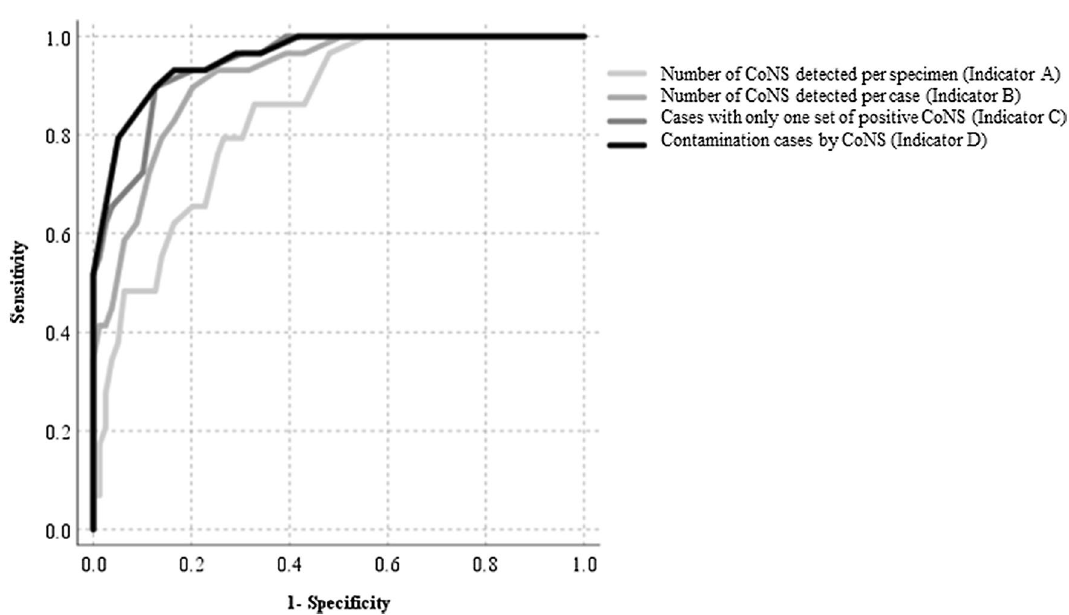
Figure 2. ROC curve predicting ConR 2.5 or higher and AUC comparison. CoNS coagulase-negative staphylococci, ConR contamination rate, AUC Area under the curve, ROC Receiver operating